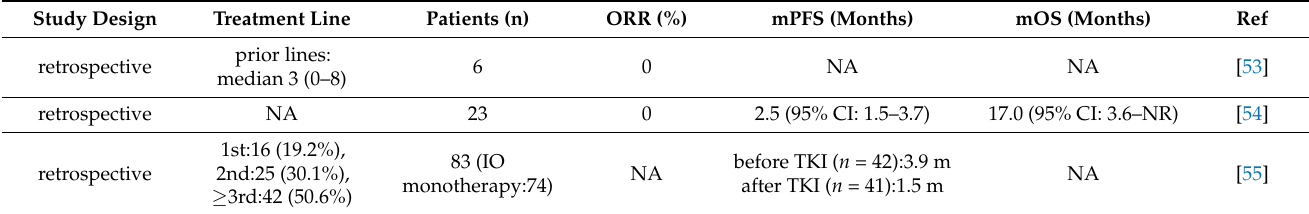
Table 5. Results of a retrospective study of IO